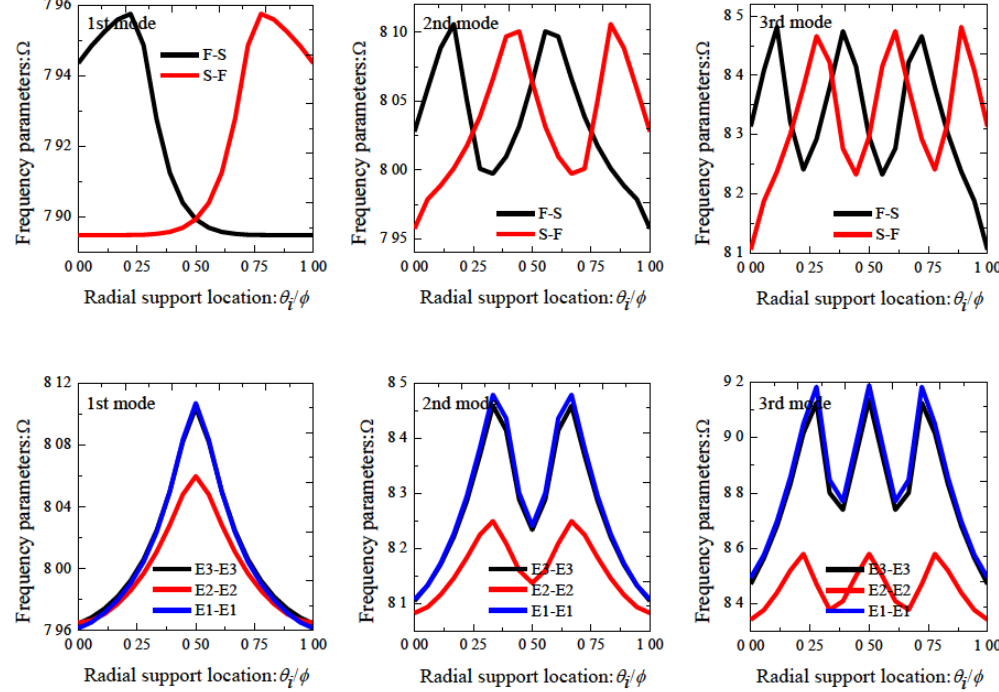
Figure 13: Variation of the frequency parameters Ω versus the radial support locations for a [0 ∘ /90 ∘ ] laminated annular sector plate with a θ direction internal radial support ( E 1 / E 2 =15, a / b =0.5, h / b =0.1, ϕ = π